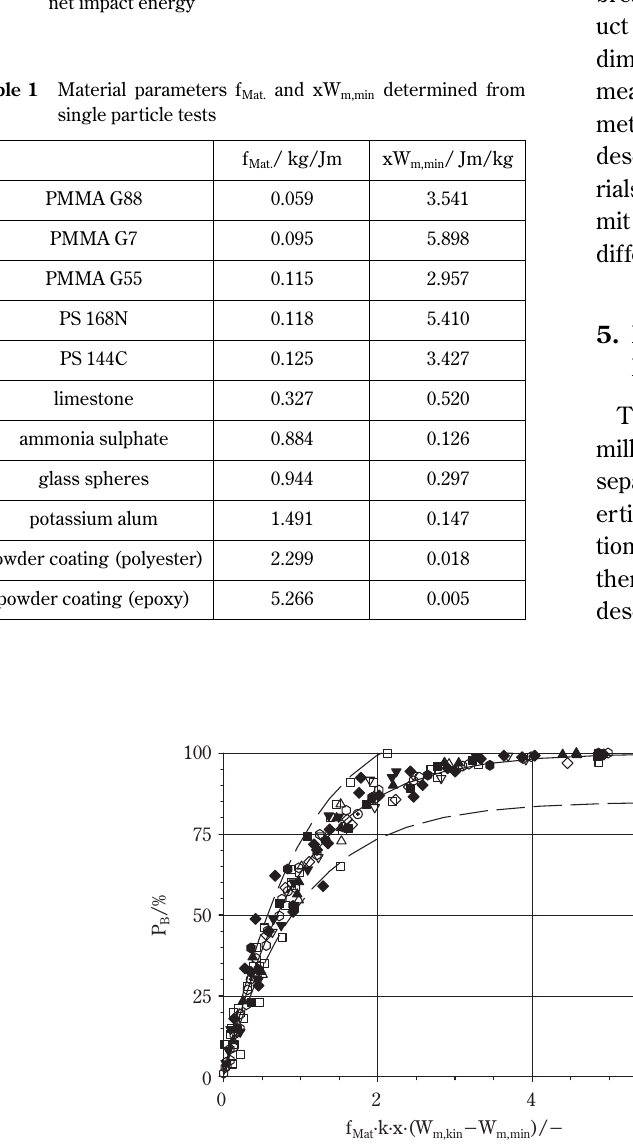
Fig. 4 Breakage probability of PMMA as a function of the total net impact